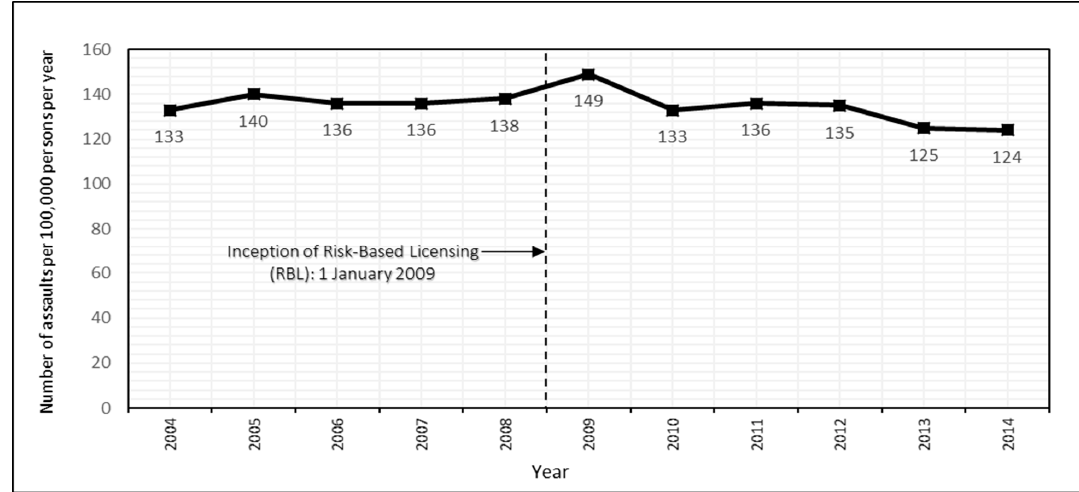
Figure 1. Crude annual assault incidence rates during “high alcohol hours” in Queensland.